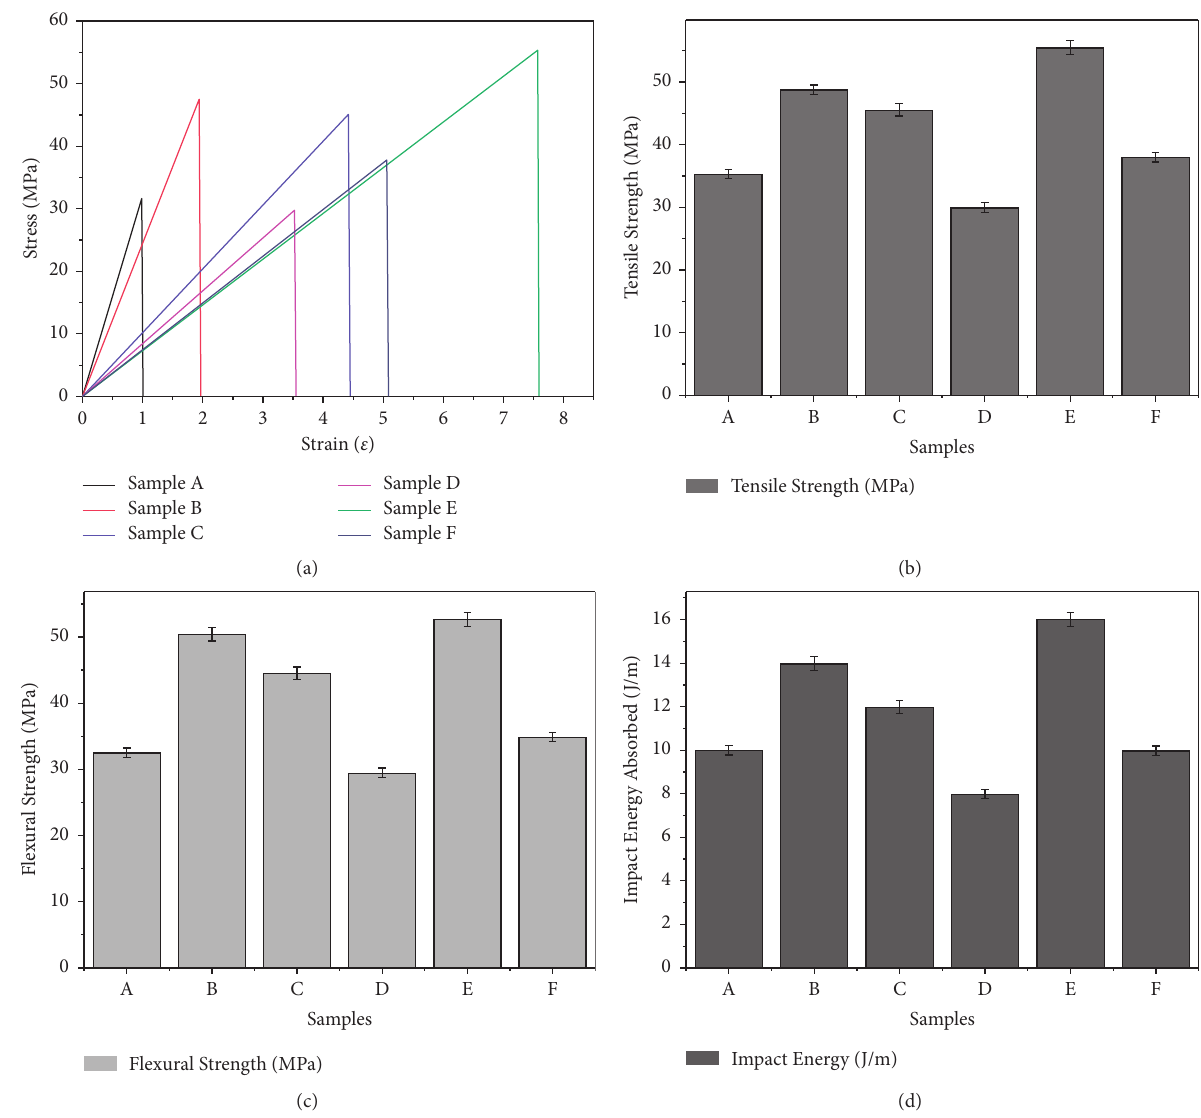
Figure 3: (a) Stress-strain curve. (b) Tensile strength of the samples. (c) Flexural strength of the samples. (d) Impact energy